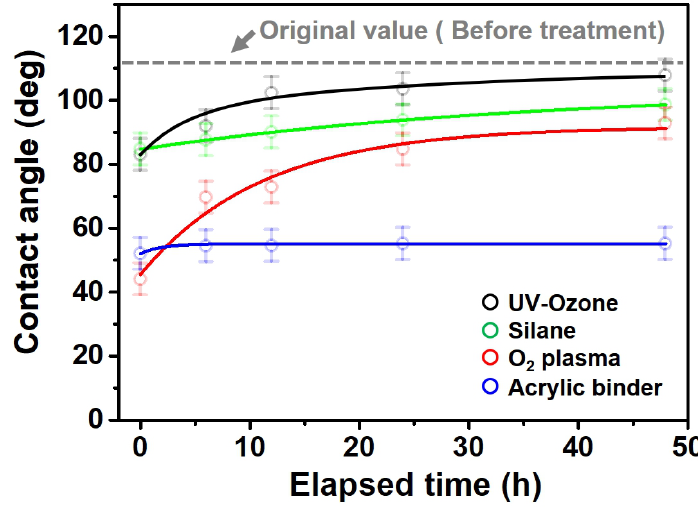
Figure 7. Contact angle change as a function of elapsed time for the recycled plastic film-based aggregates. Table 2. Effect of aging on contact angle for samples through various surface modification methods. Type of Surface Modification